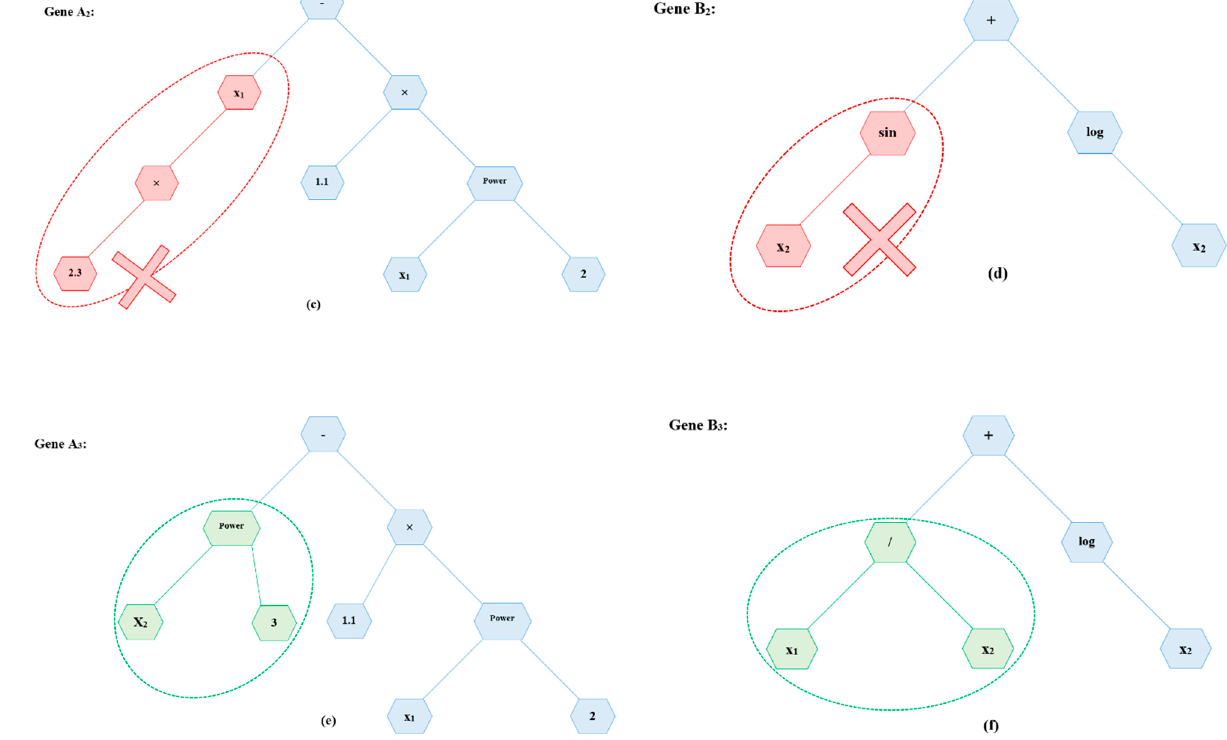
Figure 5. An example of a Multi-Gene Genetic Programming (MGGP) procedure.